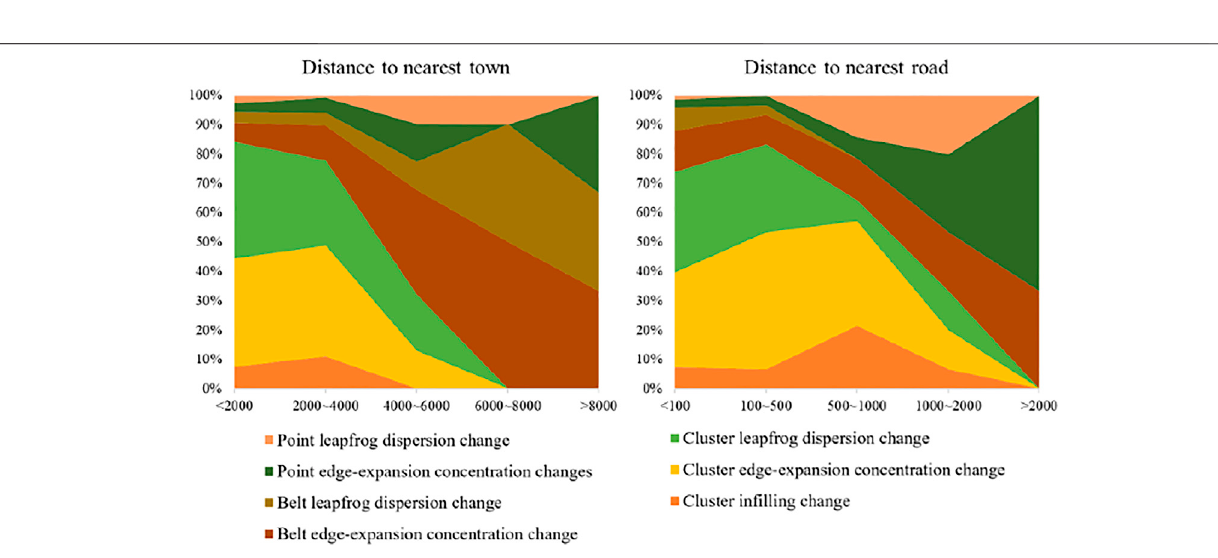
FIGURE 10 | Distribution characteristics of the dynamic spatial pattern of RRL under the location